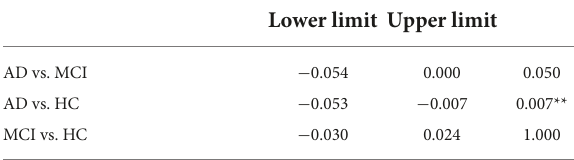
TABLE 2 Post-hoc multiple comparisons of locus coeruleus signal contrast ratios (LC-CRs) between groups. Between-group comparison 95% confidence interval P -value